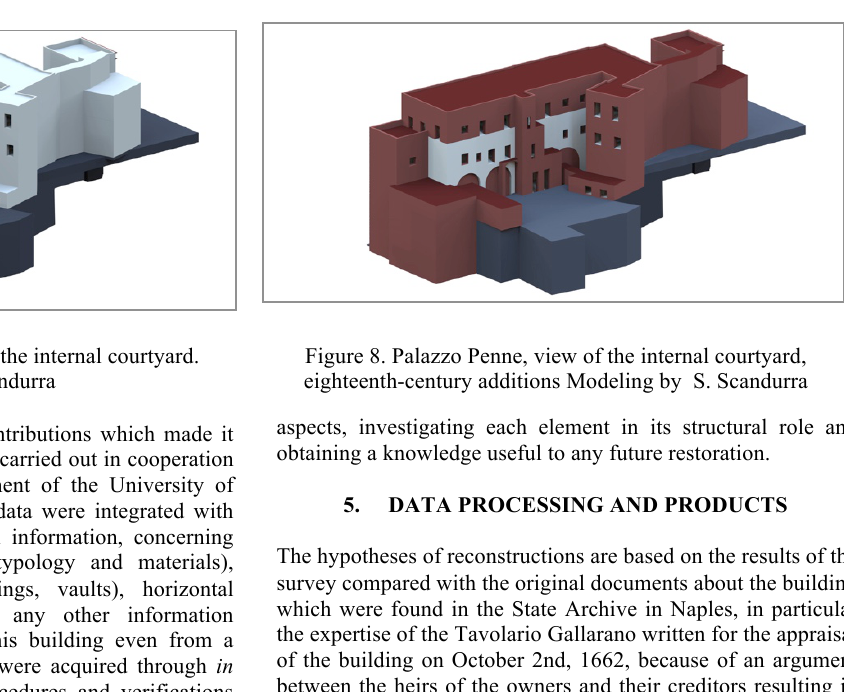
Figure 5. Palazzo Penne, view on Pendino Santa Barbara alley. Modeling by S. Scandurra